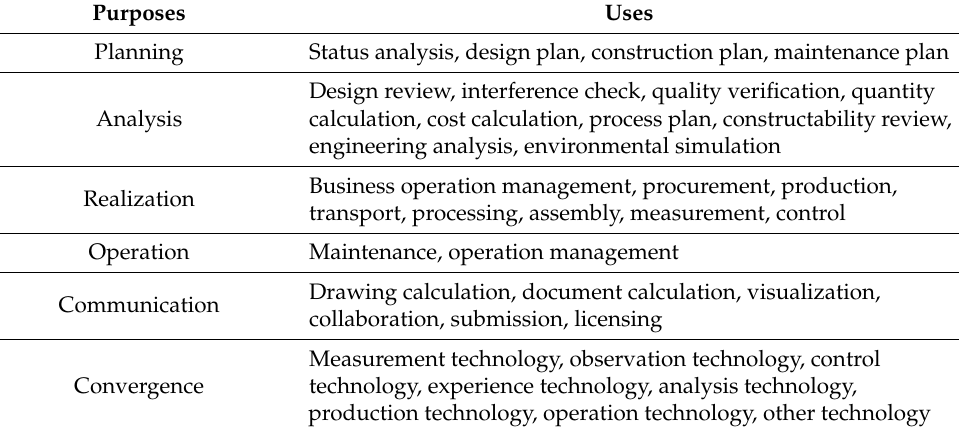
Table 2. BIM uses of KBIMS. Purposes